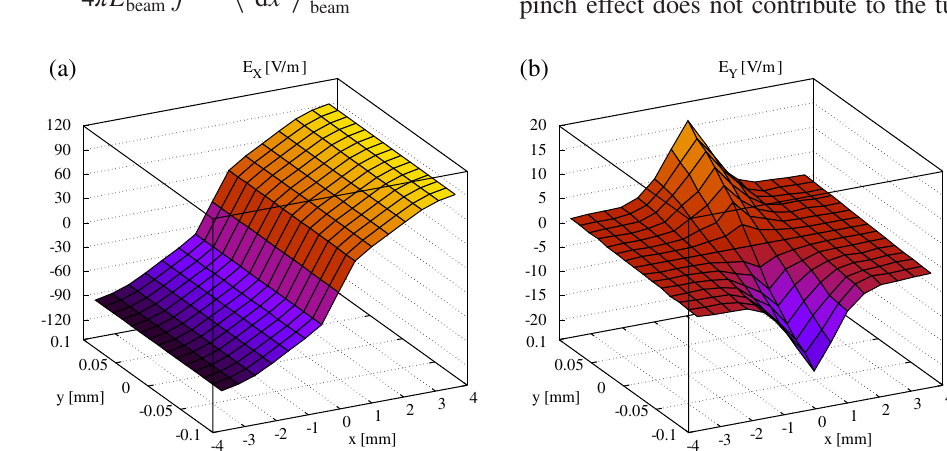
ð x; y Þ and (b) E ð x; y Þ in a region of (cid:2) 5 σ of the transverse beam size for the central X Y